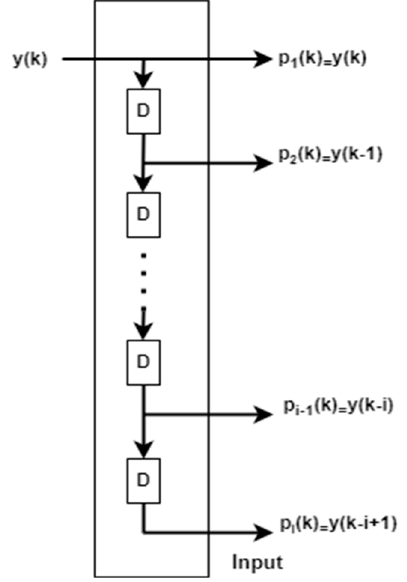
Figure 4. Structure of tapped delay line.